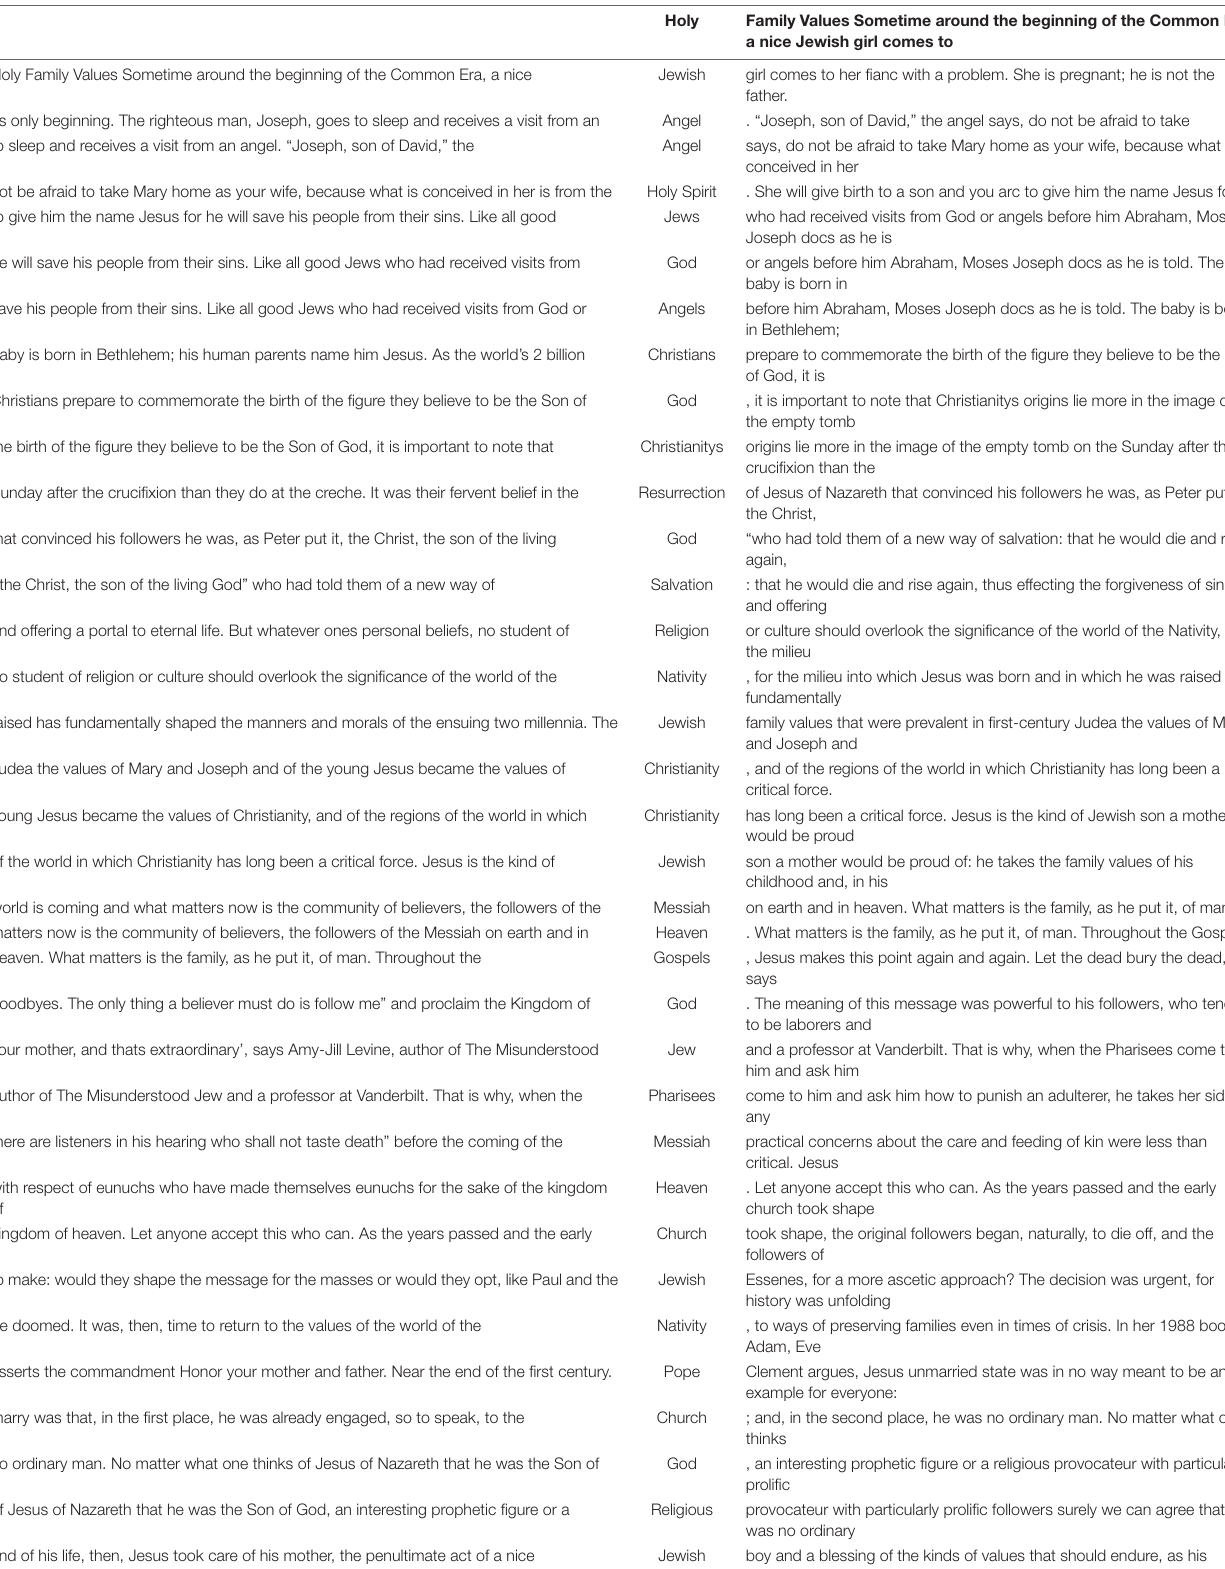
TABLE 7 | Concordance of key domain Religion and the Supernatural of the text, Holy Family Values .